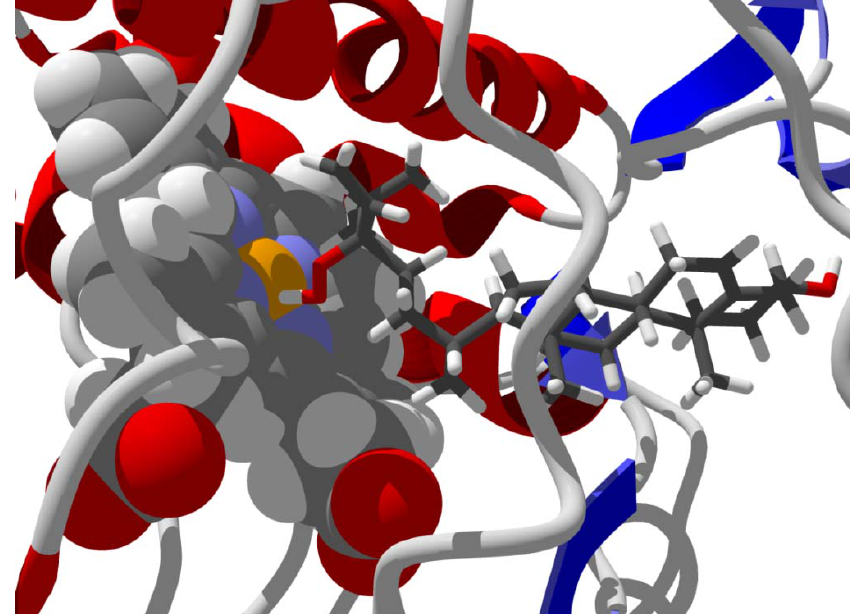
Figure 28. Lowest-energy poses of 24-hydroperoxy-24-vinylcholesterol with L. infantum sterol 14 α -demethylase (LinfCYP51, PDB 3l4d). Note the proximity of the hydroperoxy group of the ligand with the Fe atom of the heme